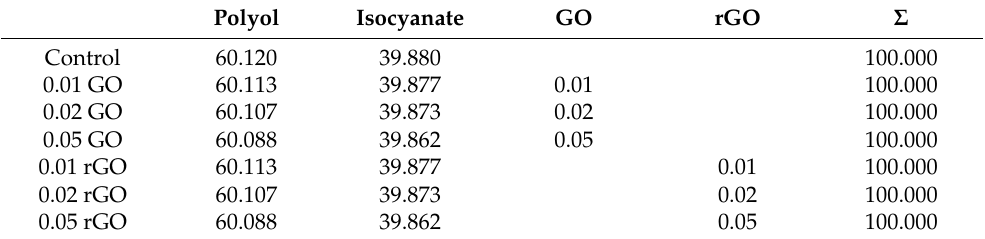
Table 1. Compositions of the films.